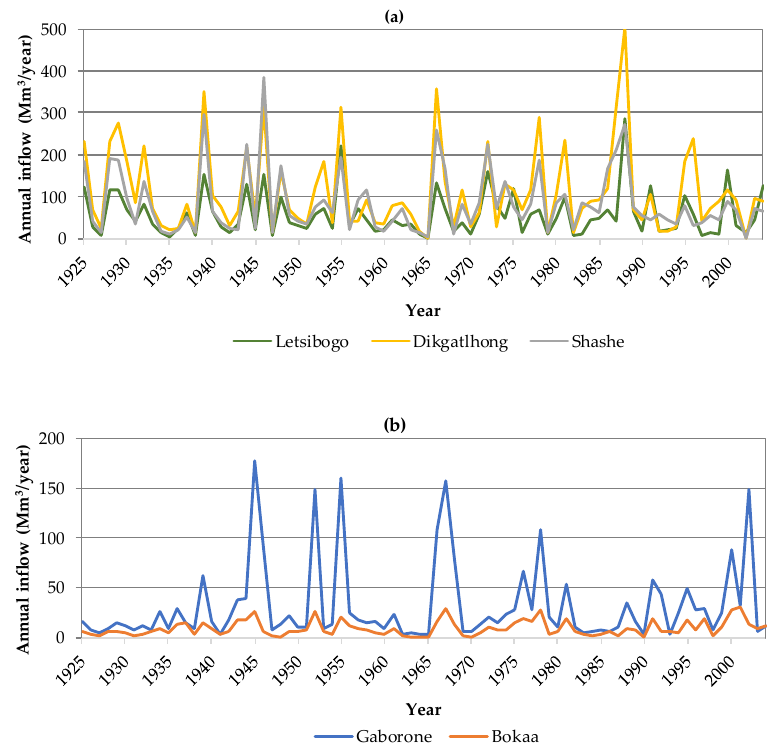
Figure 3. Historic inflow time series (80 years, 1925–2004) for the dam sites: ( a ) Letsibogo, Dikgatlhong and Shashe; ( b ) Gaborone and Bokaa [8].